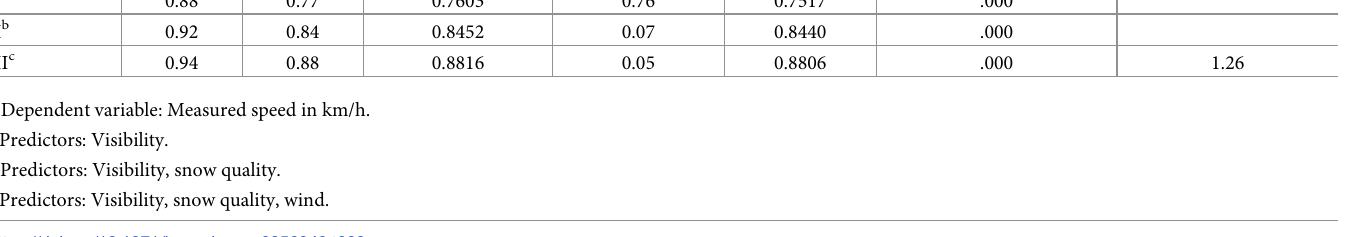
Table 3. Model summary: Effect of visibility, snow quality and wind on the measured speed � .